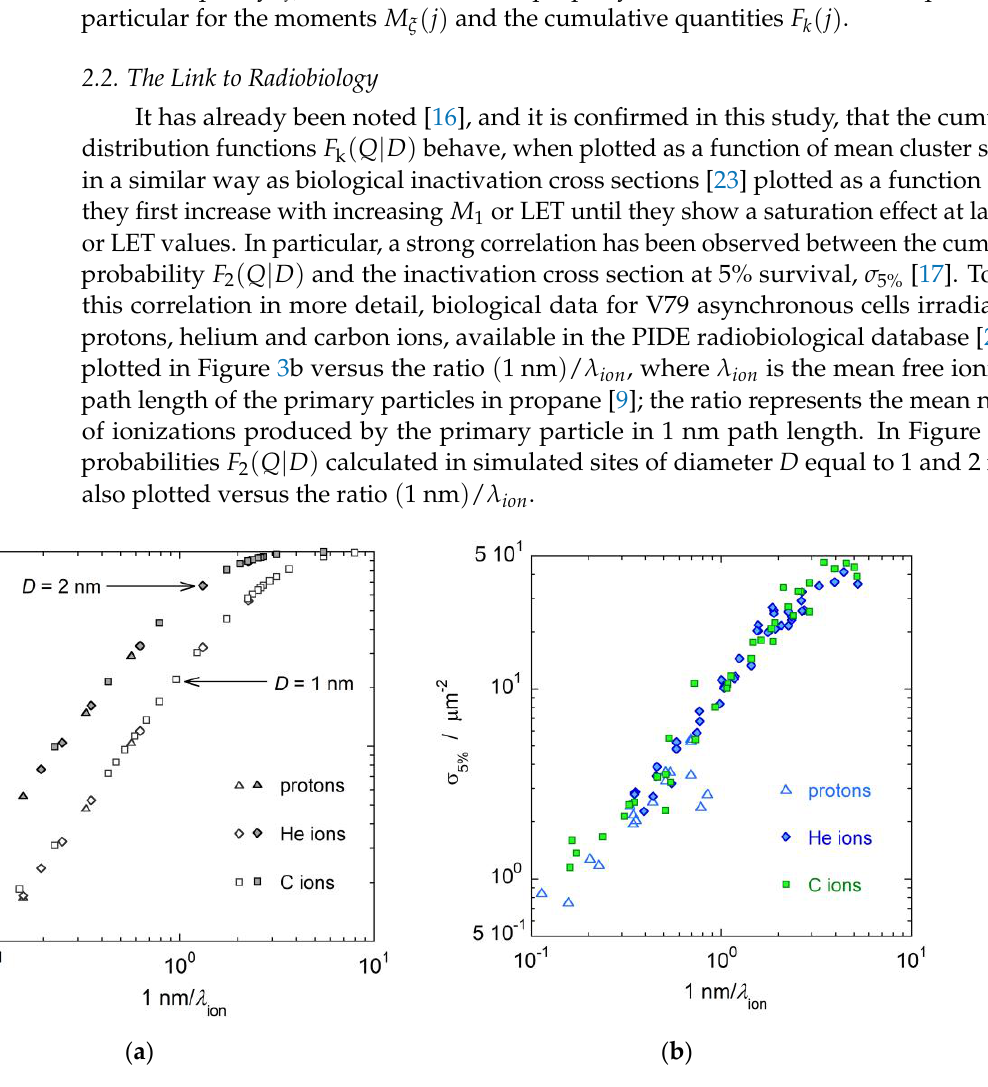
Figure 3. ( a ): The cumulative probabilities 𝐹 2 (𝑄) , calculated in target volumes with D = 1 nm and D = 2 nm, are plotted versus the ratio (1 nm)/𝜆 𝑖𝑜𝑛 . ( b ) The biological inactivation cross sections at 5% survival level for V79 cells irradiated by protons, helium and carbon ions [17], plotted versus the ratio (1 nm)/𝜆 𝑖𝑜𝑛 . See text for more details.